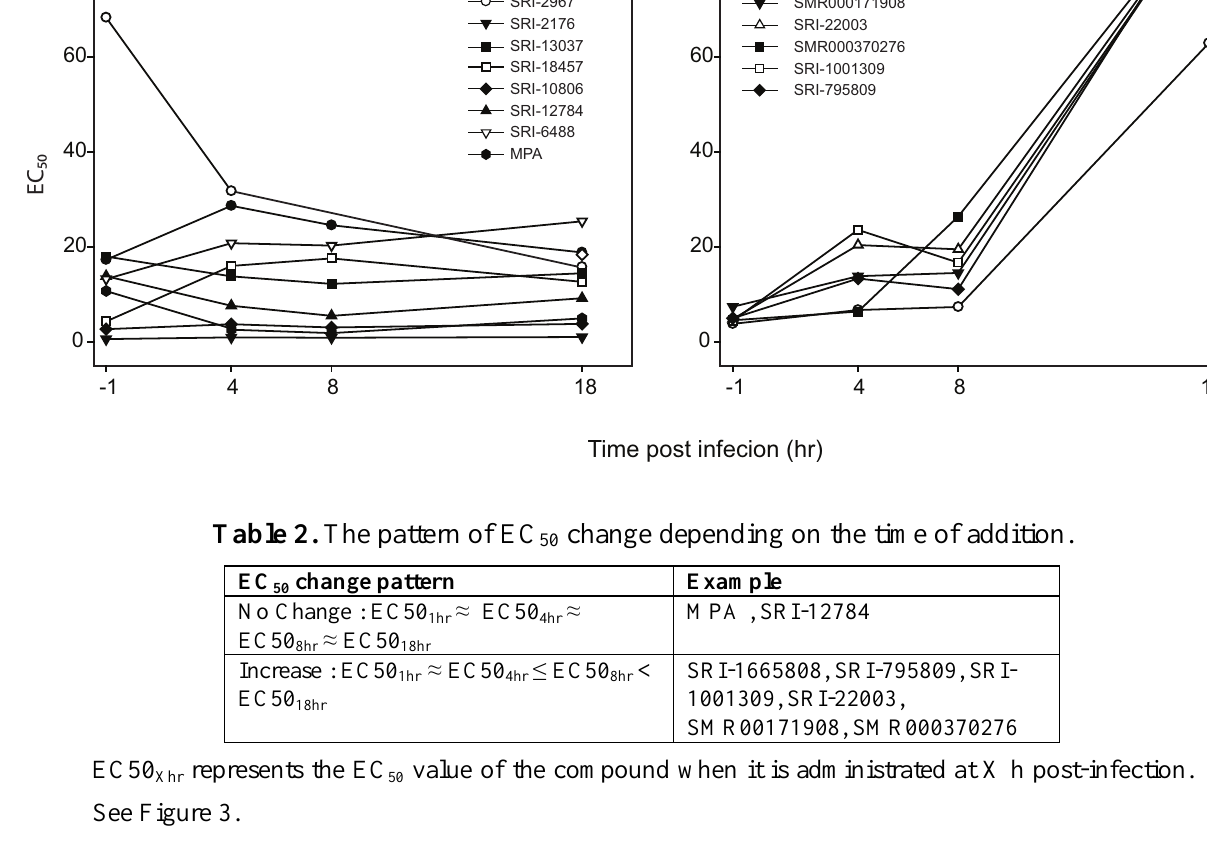
at different times post-infection. Dose response 50 calculated as 50 within 50 50 calculated was higher than 60 µM. For 50